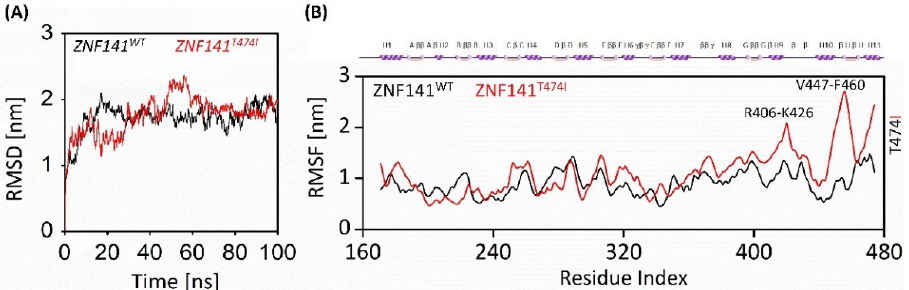
Figure 3. Post MD simulation analysis of ZNF141 WT and ZNF141 T474I proteins along the course of 100ns MD simulation. ( A ) RMSD of wt-ZNF41 and variant T474I represents the overall instability of the ZNF141 T474I ( B ) RMSF plots for wt-ZNF41 and variant ZNF141 T474I . Residues R406-K426 and V447-F460 have shown large variations in terms of flexibility. The secondary structure elements are also shown over the RMSF plot. The black color indicates ZNF141 WT , and the red color is for mutant T474I.